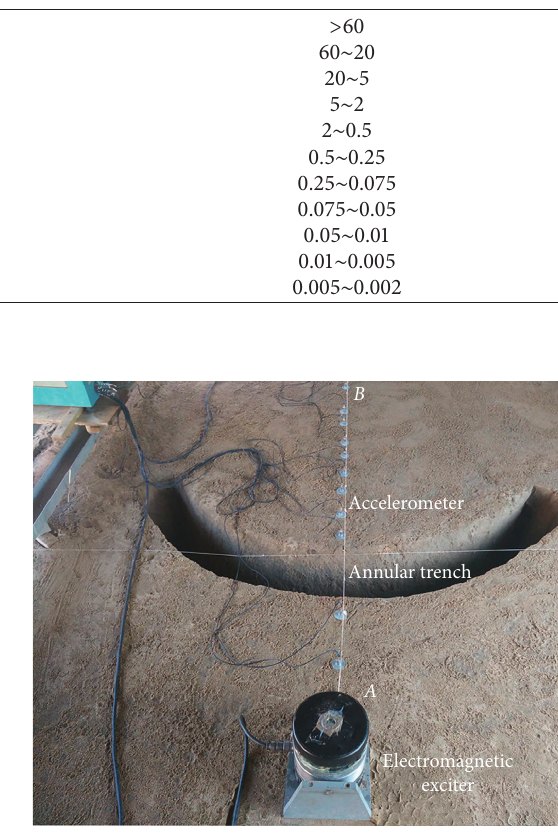
Figure 2: Test site and